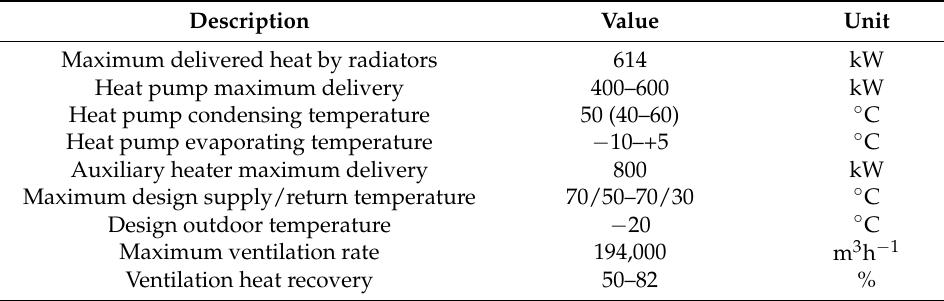
Table 1. Main inputs used for the entire simulation